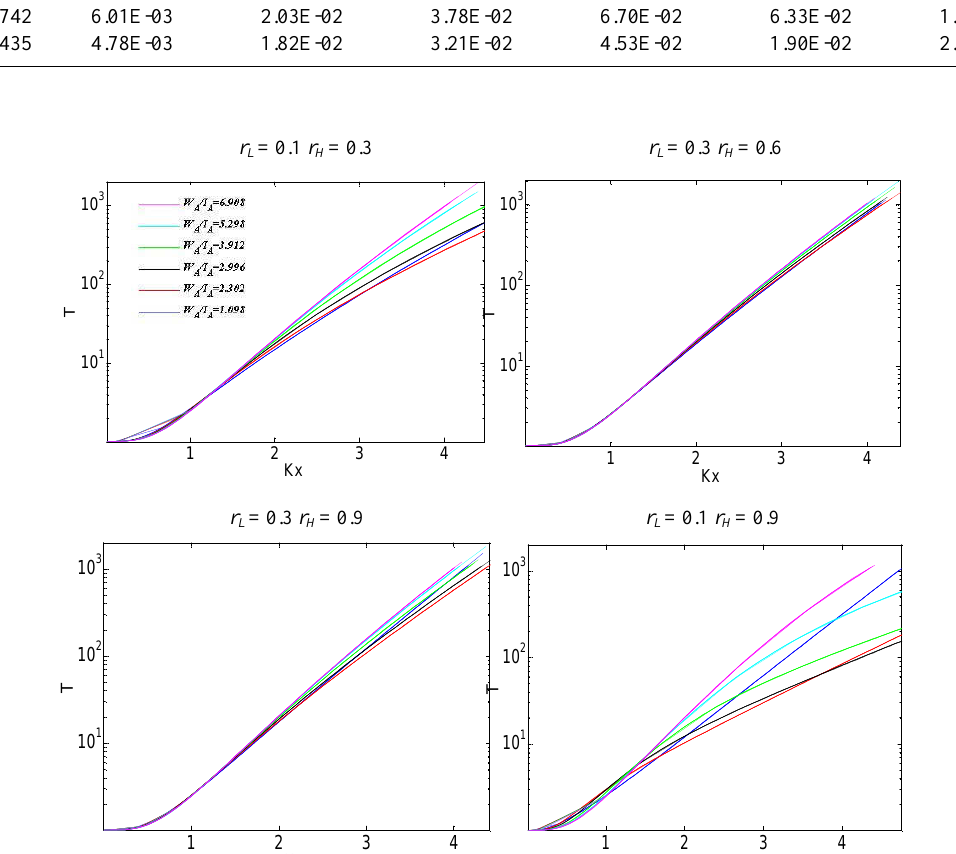
Fig. 3. Growth curves obtained for a constant value of φI A (0.742), and varying W A /I A (as in the legend), I 1 (10, 50 mmh − 1 ), A (10, 50, 100, 200, 500km 2 ), r L and r H (in subplots).